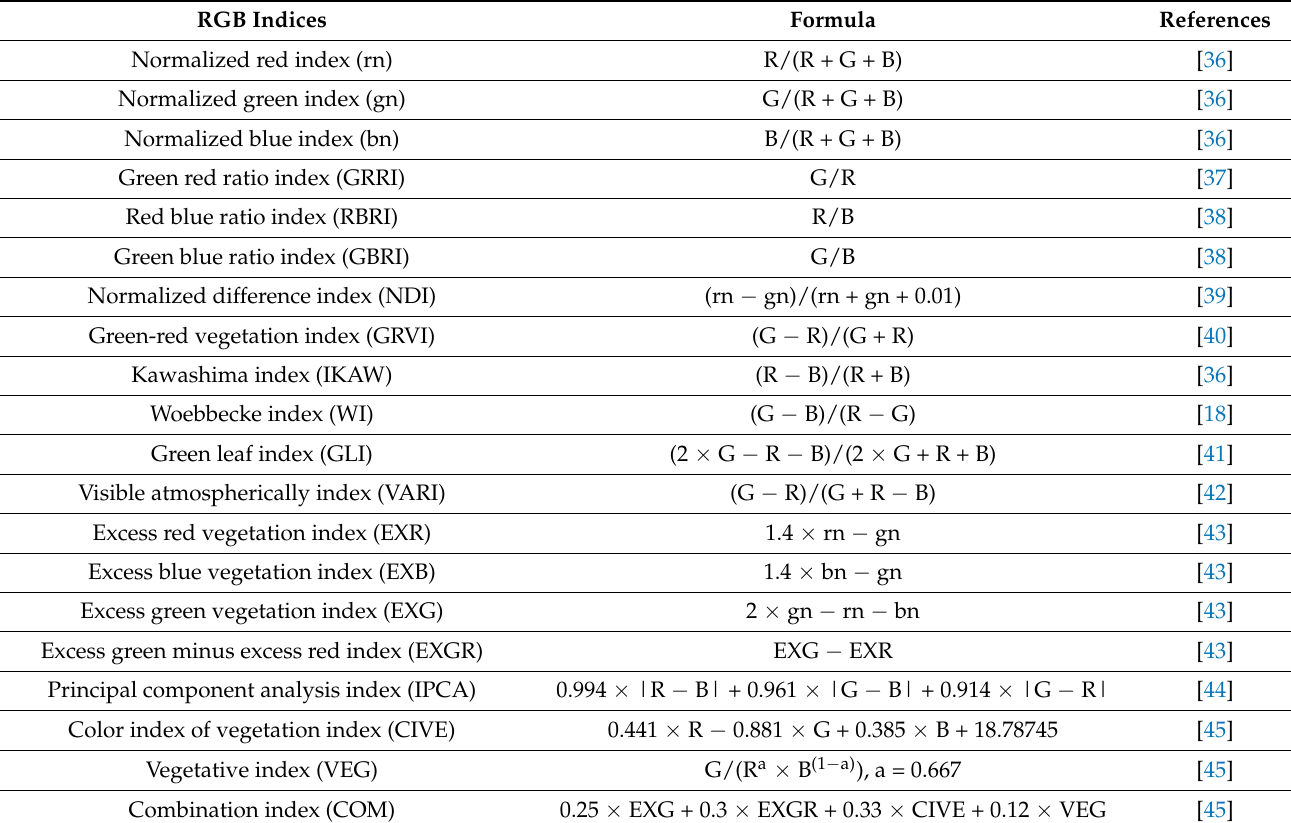
Table 2. Description of different RGB imagery indices tested in this